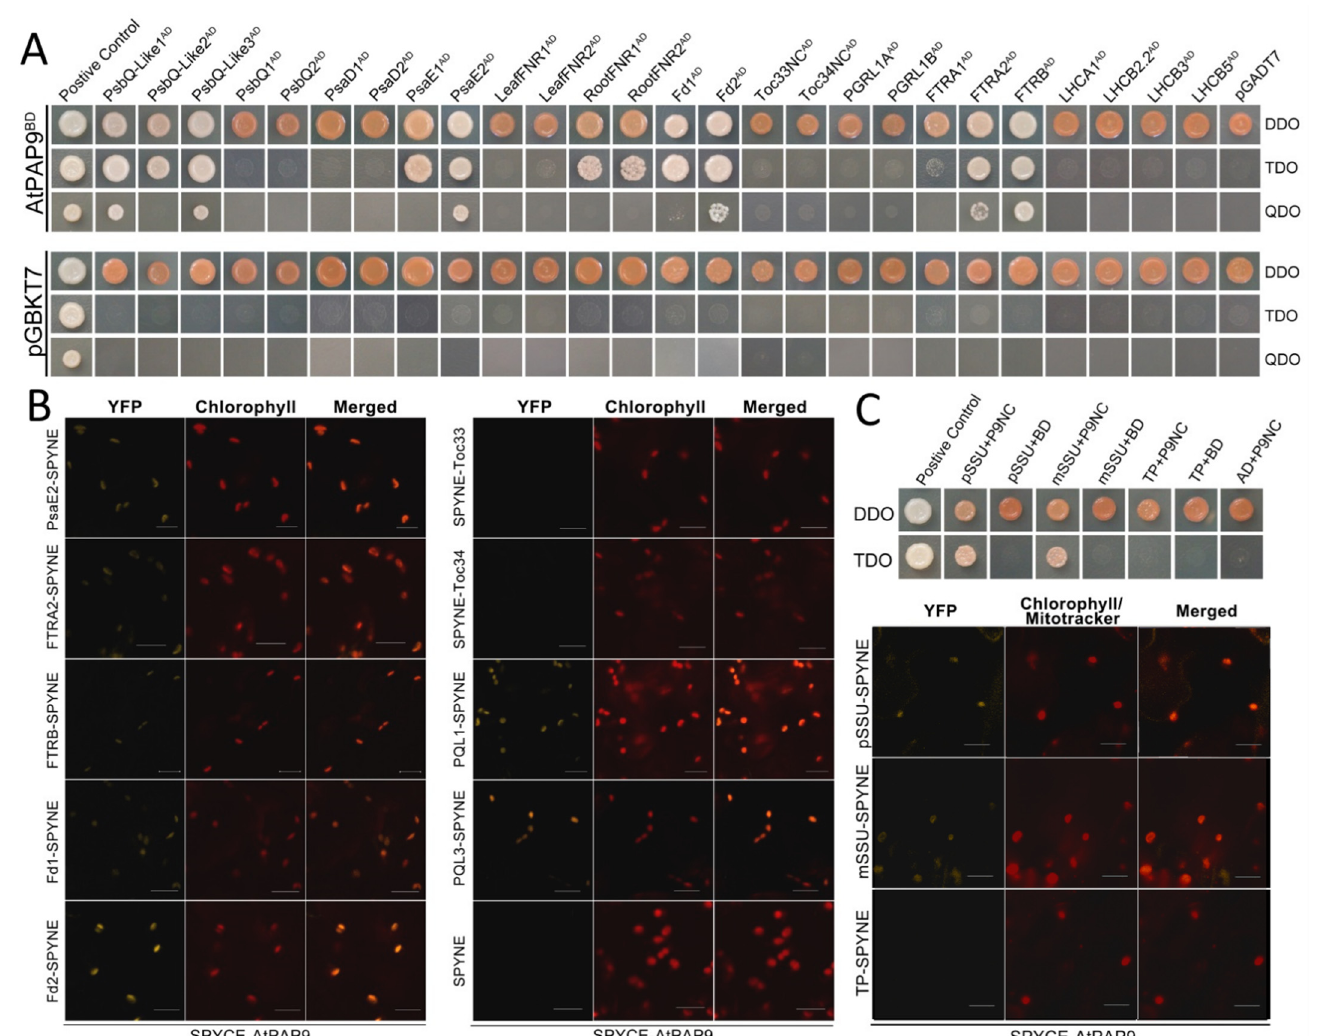
Figure 3. AtPAP9 interacted with a number of chloroplast proteins. ( A ) In Y2H assay, AtPAP9 without its signal peptide and C-terminus (a.a. 21–605, P9NC) was used as the bait and cloned into the pGBKT7 BD vector. It was then co-transformed with the pGADT7 AD vectors carrying the prey. To test for auto-activation, blank pGBKT7 BD vector and pGADT7 AD vector were co-transformed with the bait and prey, respectively. The yeast transformants were diluted 10x and selected on double-dropout (DDO, SD/-Leu/-Trp), triple-dropout (TDO, SD/-Leu/-Trp/-His), and quadruple-dropout (QDO, SD/-Ade/-Leu/-Trp/-His) media. Yeast colonies grown on DDO medium indicated that both bait and prey vectors were successfully transformed into the cells, while yeast colonies grown on TDO and QDO media indicated medium and strong interaction of the bait and the prey in the yeast cells, respectively. pGBKT7-53 and pGADT7-T vectors were used as positive controls. ( B ) BiFC assay was carried out to confirm the interaction between AtPAP9 and the interacting proteins. YFPN-fused chloroplast proteins and YFPC-AtPAP9 were co-expressed in tobacco leaves by syringe injection. Empty SPYNE vectors were used as negative controls. Reconstituted YFP fluorescence was excited at 515 nm and detected with a PMT detector at an emission bandwidth of 530–550 nm (left panel). Chlorophyll autofluorescence was excited at 488 nm and detected with a PMT detector at an emission bandwidth of 650–710 nm (middle panel). An overlay of the YFP signal and the chlorophyll autofluorescence is shown in the right panel. Scale bars = 20 μ m. All images were captured at the same gain settings as the corresponding PMT channels. ( C ) AtPAP9 interacted with pSSU (a.a. 1–181) and mSSU (a.a. 42–181) but not with the transit peptide of SSU (TP, a.a. 1–50 of pSSU) in Y2H and BiFC assays.